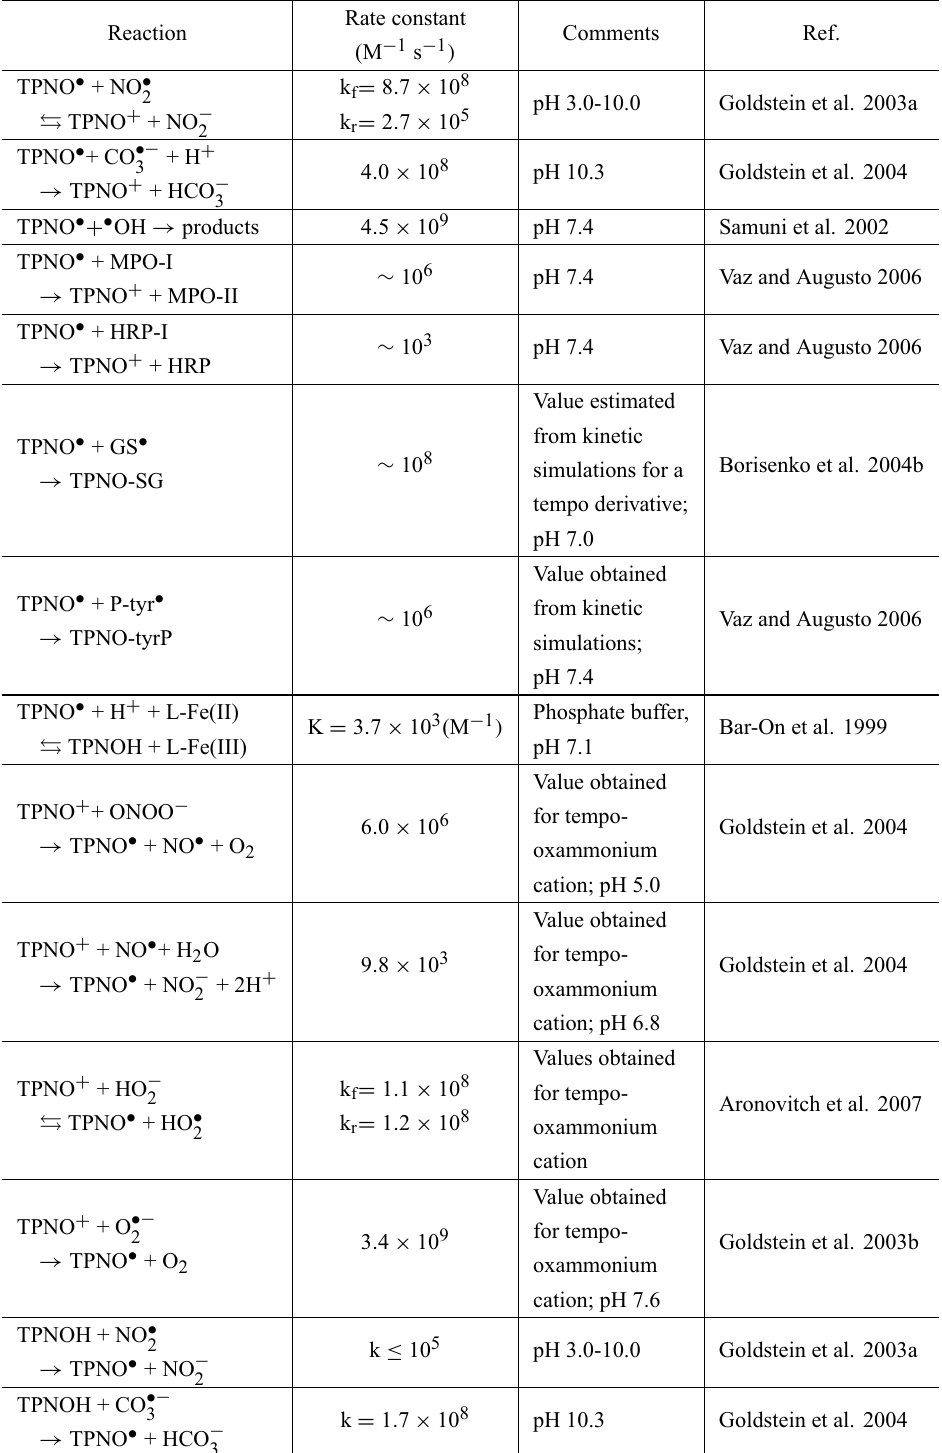
Reactions of tempol (TPNO • ) , oxammonium cation (TPNO + ) and hydroxylamine (TPNOH) with biological intermediates and the corresponding second order rate